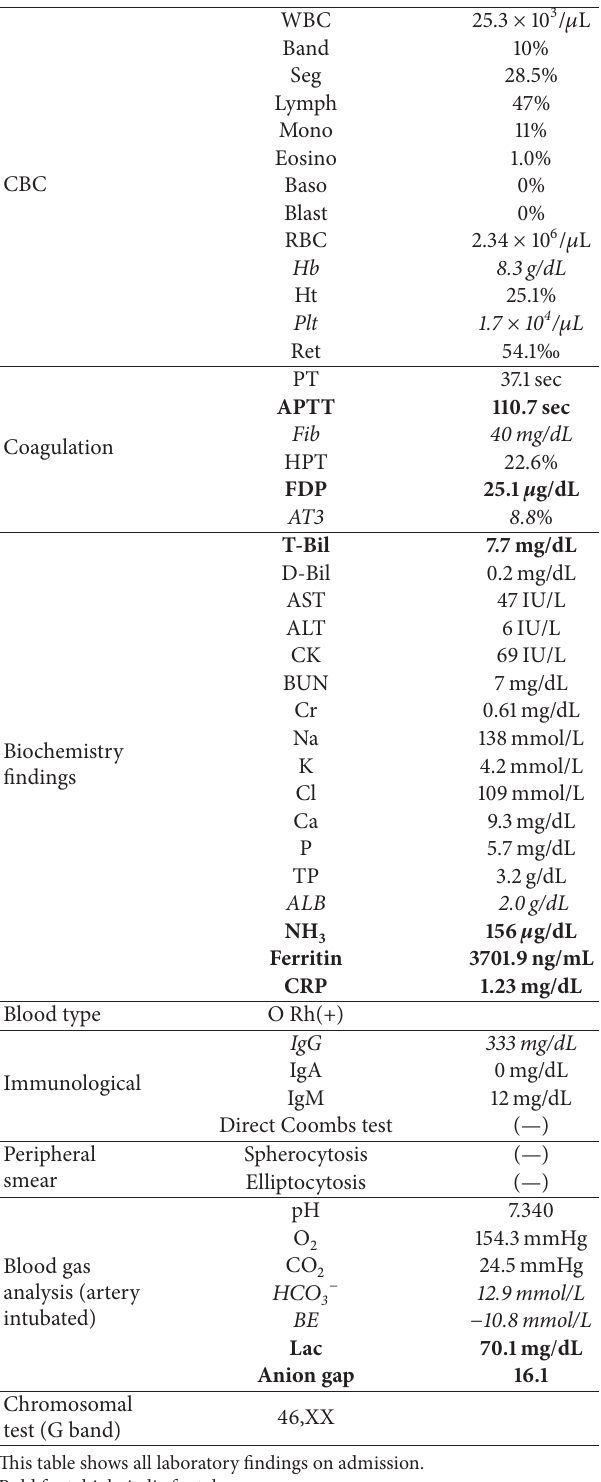
Table 1: Laboratory findings on